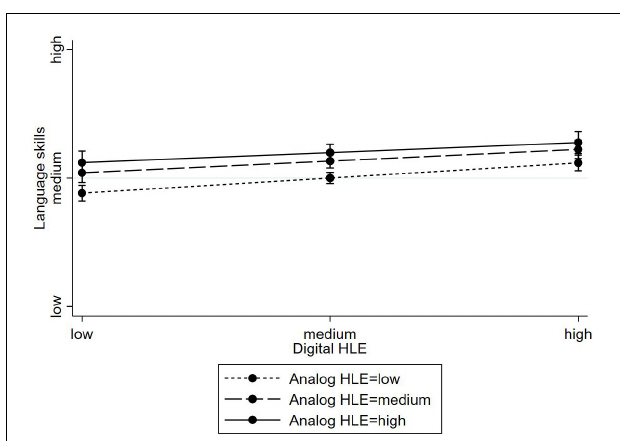
FIGURE 2 | Moderating effects of analog HLE on the association between digital HLE and language skills (preschooler age